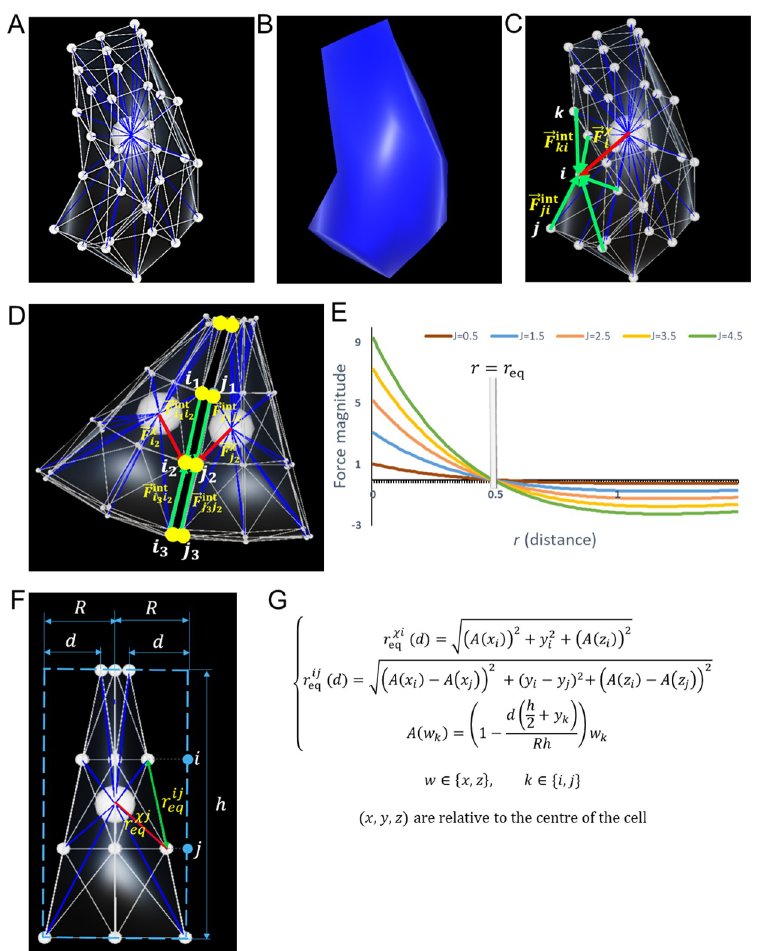
Fig 2. Computational model. A . 3D representation of a cell: The cell is abstracted by an agglomeration of particles (small white spheres, 34 in the picture), whose triangulation (white edges) forms the membrane, and by an intracellular particle (big white sphere). Interactions between the intracellular and membrane particles (blue lines) mimic the cytoskeleton. B . 3D rendering of a cell without its sub-cellular elements. C . Forces acting within a cell: ~ F int forces that membrane particles j , k exert on another membrane particle i . ~ F w exerts on i . D . External forces acting on a cell via its particles. Here, ~ F ext magnitude of Morse forces under different values of J , with ρ = 1 and r eq = 0.5. F . Apical constriction of an epithelial cell with original radius R shrinking by d . G . Formulas of the new equilibrium lengths in an apically constricted